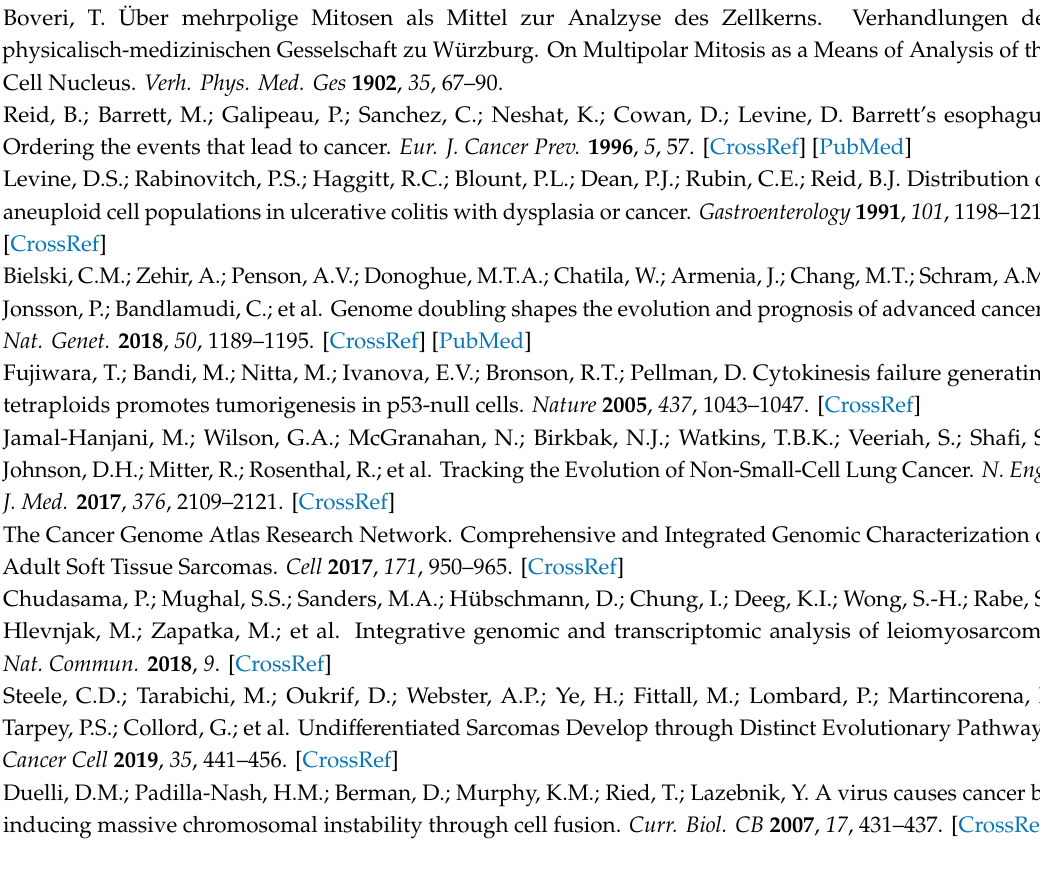
Figure S1: Fluorescence analysis, Figure S2: Genomic analysis of hybrid cells lines at early and late passages shows evolution of genomes, Figure S3: Late passage cell lines developed more tumors than early passage cell lines, Figure S4: Characterization of hybrid tumors developed in mice, Figure S5: Genomic profiling, Figure S6: Transcriptomic program is remodeled toward oncogenesis, Figure S7: Identification and validation of DMD deletions in hybrid tumors, Figure S8: Signal detection on the whole membrane shown on Figure 6A, Figure S9: Detection of Dp427 and other dystrophin isoforms by immunofluorescence analysis, Table S1: Genes used to cluster the samples into four